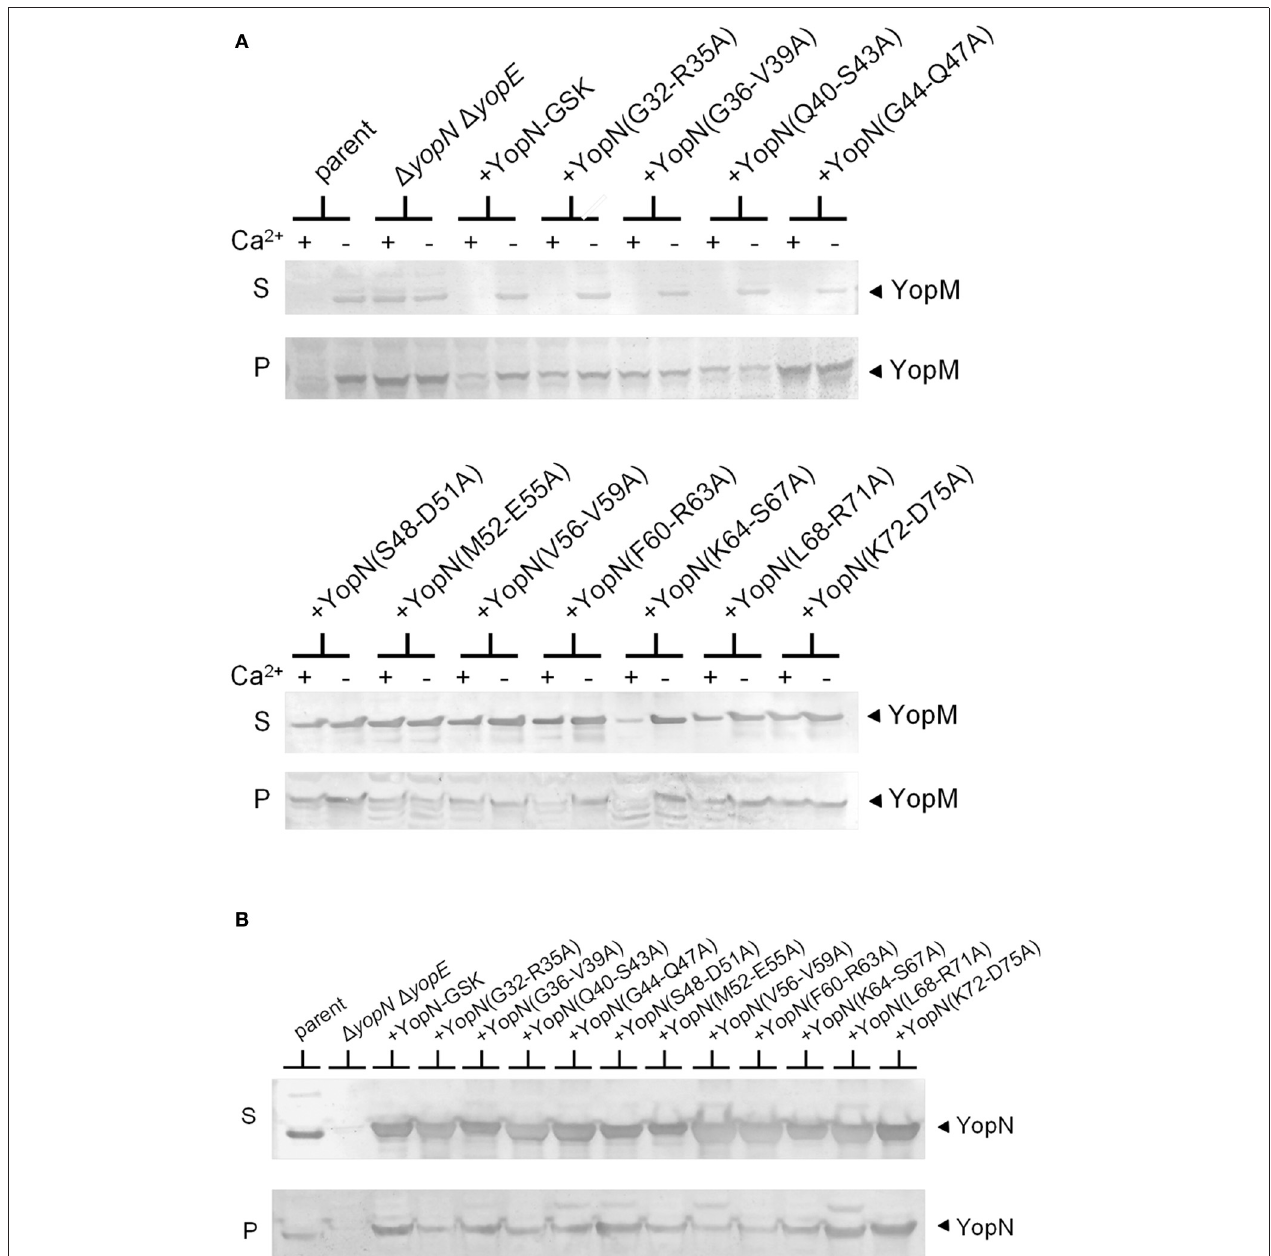
FIGURE 2 | Residues within the YopN CBD are required to regulate Yop secretion. A series of tetra-alanine substitution mutants were constructed within YopN CBD residues 32–75. (A) Expression and secretion of YopM by Y. pestis strains expressing YopN CBD tetra-alanine mutants. KIM8.P39 ( (cid:2) yopE parent), KIM8.P62 ( (cid:2) yopN (cid:2) yopE ), and KIM8.P62 transformed with either pBAD30-YopN-GSK or one of eleven pBAD30-YopN-GSK derivatives encoding YopN CBD tetra-alanine substitution mutants were